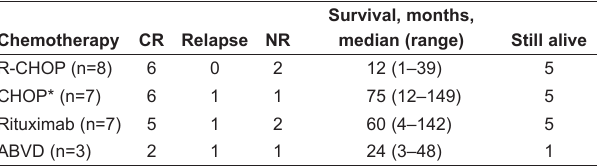
*Two patients were treated with cyclophosphamide, hydroxydoxorubicin, vincris- tine (Oncovin, Eli Lilly, USA) and prednisone (CHOP) after failure of rituximab monotherapy; ABVD Adriamycin, bleomycin, vinblastine and dacarbazine;